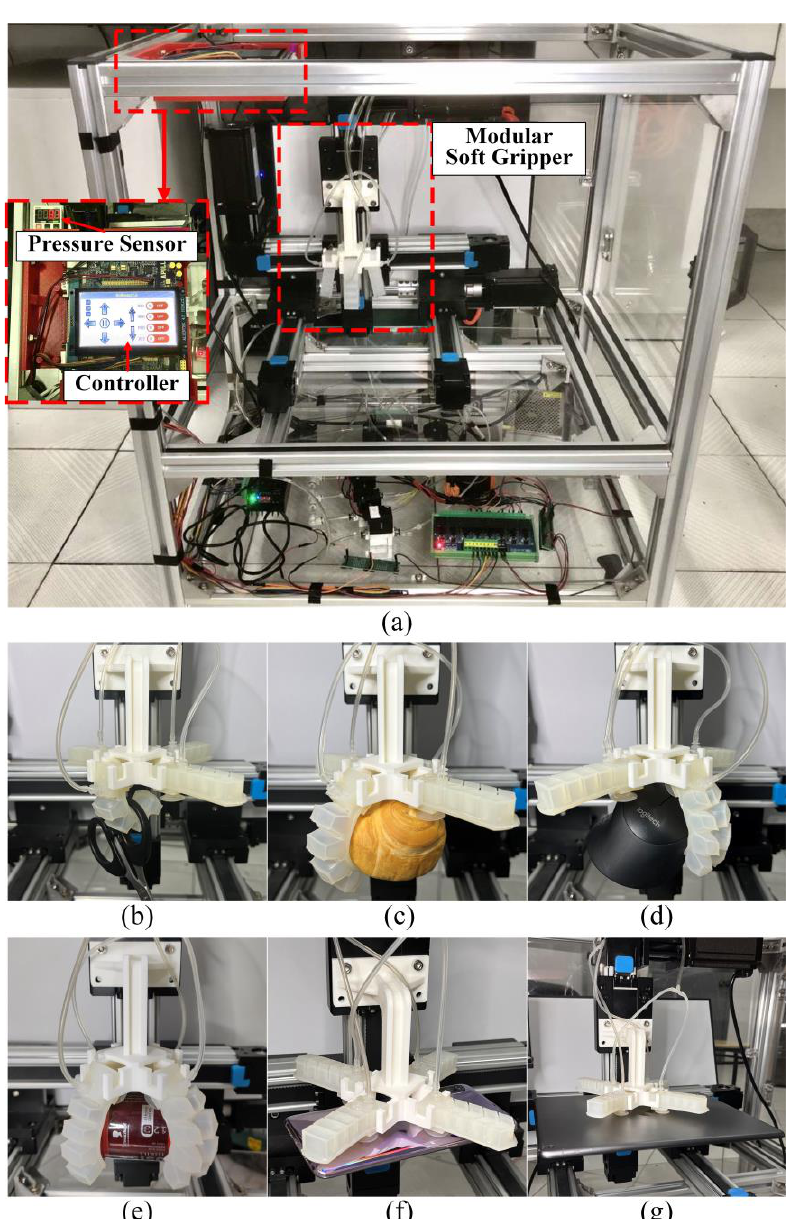
Figure 9. Picture of the automatic equipment loading the modular soft gripper ( a ) and snapshots of various object lifting applications on: ( b ) a scissor, ( c ) a bread, ( d ) a mouse, ( e ) a jar, ( f ) a mobile phone, and ( g ) a laptop.